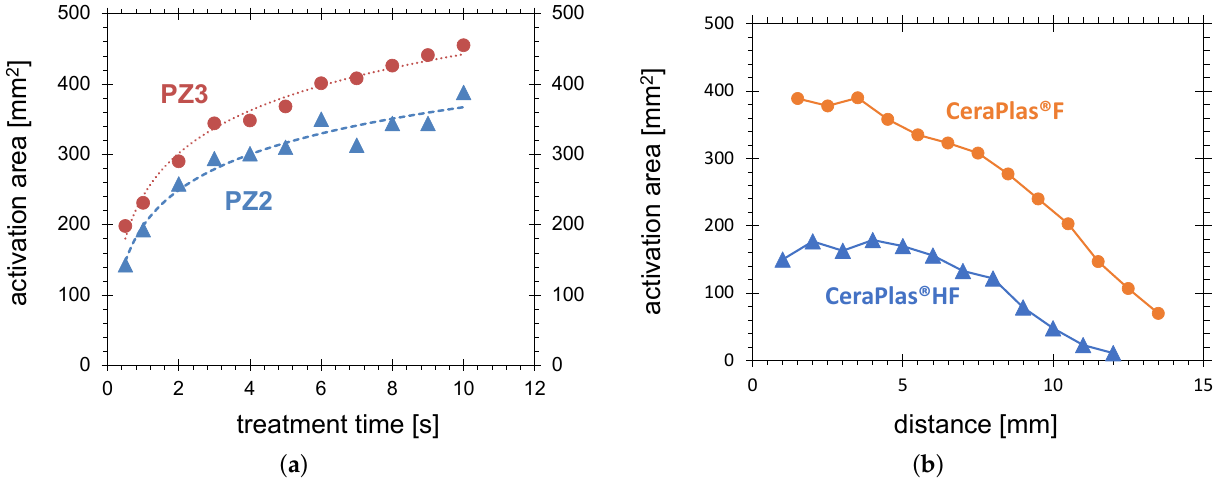
Figure 9. The activation area of the piezobrush ® PZ3 operated with the power of 8.0 W. ( a ) the dependence on the treatment time for PCPG positioned in the distance of 4.5 mm from the HDPE substrate. For comparison, the results for piezobrush ® PZ2 are included [51]; ( b ) the dependence on the distance for the treatment time of 10 s [11]. For comparison— the results obtained with 72 mN/m test ink on ABS substrates using the CeraPlas™HF with 4.0 W power and no air flow positioned 4.5 mm from the